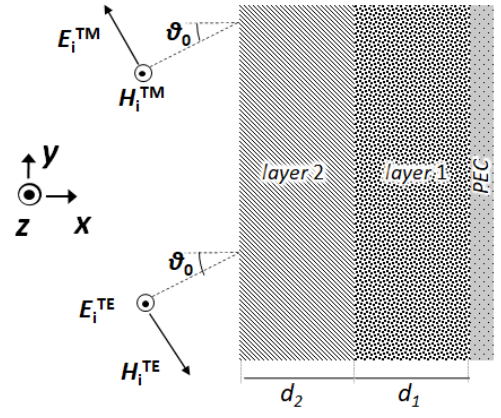
Figure 1. Absorber structure consisting of a PEC-backed polymer dielectric spacer (layer 1) and a graphene-based lossy sheet (layer 2). E iTM(TE) and H iTM(TE) are the incident electric and magnetic fields in case of TM or TE polarizations.